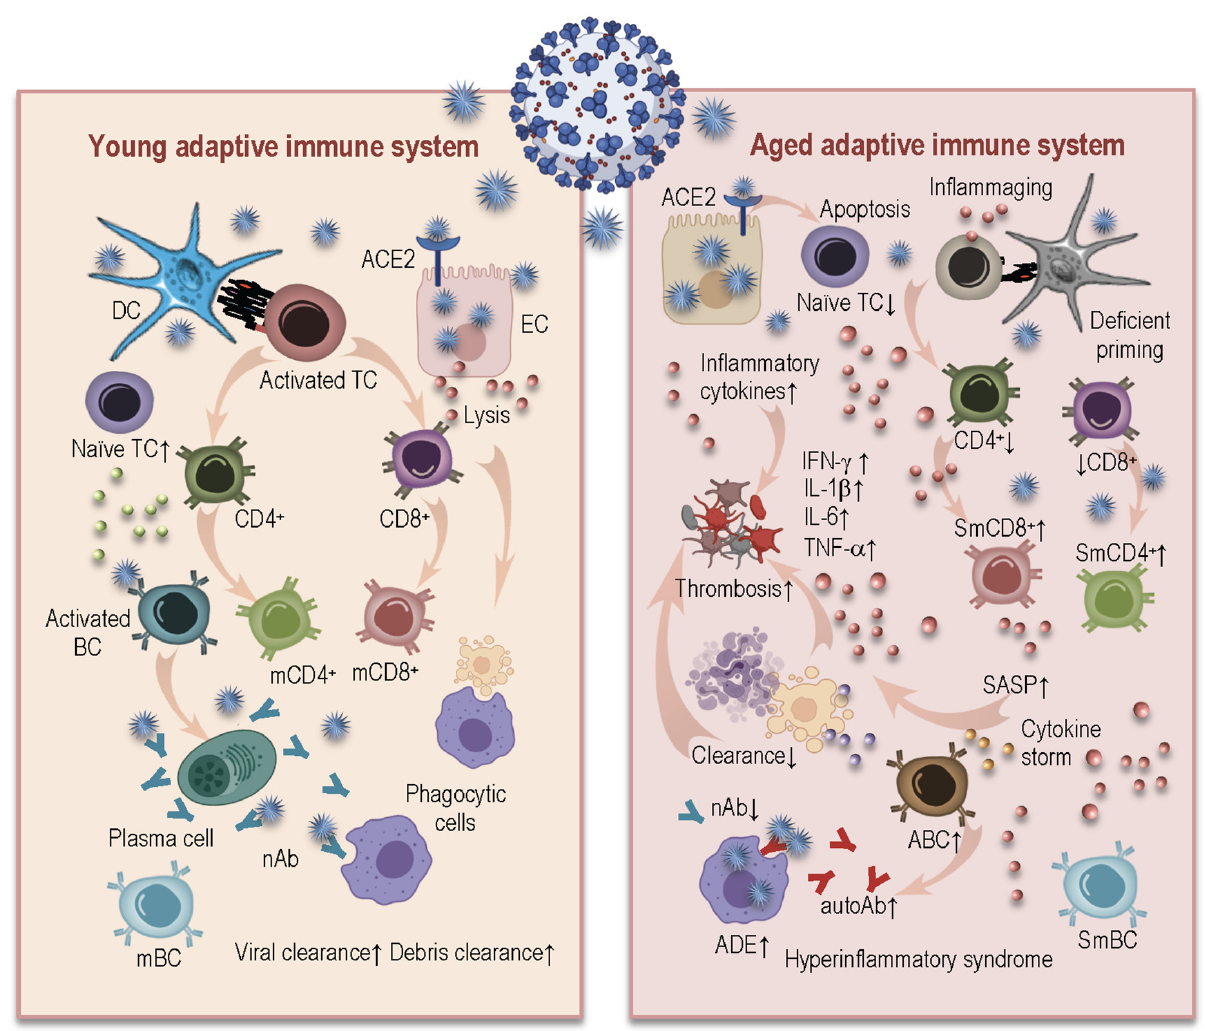
Figure 4. Age-related changes in the adaptive immune system and their impacts on SARS-CoV-2 infection. The SARS-CoV-2 virus can be recognized by dendritic cells of the young immune system ( left ), which release cytokines and present antigens to naïve T-cells for their priming and activation. CD4 + T-cells release cytokines and activate B-cells and plasma cells for the production of nAb. Cytotoxic CD8 + T-cells are able to directly kill infected cells, preventing the spread of the virus. Neutrophils migrate to the sites of infection to clear infected cell debris. This immune response is capable of resolving the infection and establishing the immune memory. Aged cells of the adaptive immune system ( right ) have multiple deficits which prevent effective antiviral immunity. Decreased numbers of naïve T-cells, limited repertoires of receptors, accumulations of senescent late-differentiated T-cells with decreased proliferative ability, and elevated levels of pro-inflammatory cytokines contribute to the inefficient immune response to the virus. Additionally, severe COVID-19 is characterized by reduced numbers of CD4 + and CD8 + T-cells. Age-associated B-cells may produce inflammatory cytokines, in particular, TNF- α , affecting the generation of mature B-cells. The reduction in nAb and the elevated levels of non-neutralizing antibodies and autoAb may worsen SARS-CoV-2 infections through ADE, further exacerbating organ damage. SASP mediators, inflammaging, and autoimmunity promote a pro-thrombotic environment, thereby contributing to the hyperinflammatory response observed in severe COVID-19. DC: dendritic cell; EC: endothelial cell; ACE2: angiotensin-converting enzyme 2; TC: T-cell; CD: cluster of differentiation; BC: B-cell; mCD4+: memory helper cell; mCD8+: memory cytotoxic T-cell; mBC: memory B-cell: nAb: neutralizing antibody; IFN: interferon; TNF: tumor necrosis factor; IL: interleukin; SASP: senescence-associated secretory phenotype; SmCD8+: senescent memory CD8+ T-cell; SmCD4+: senescent memory CD4+ T-cell; SmBC: senescent memory B-cell; ABC: age-associated B-cells; ADE: antibody-dependent enhancement. Aged cells of the adaptive immune system have multiple deficits which prevent effec- tive antiviral immunity (Figure 4, right). The restricted T-cell diversity that was